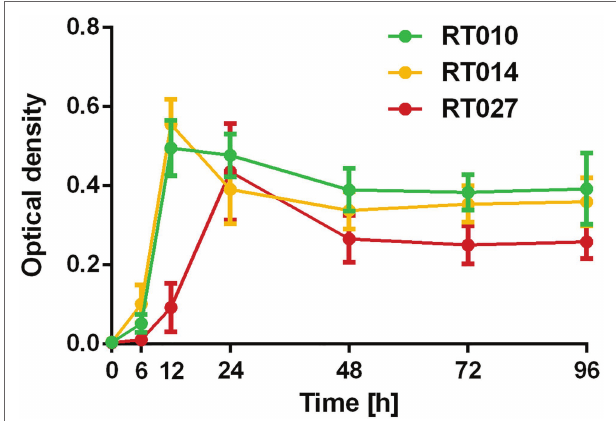
FIGURE 2 | Growth curve of C. difficile RT010 (green), RT014 (yellow), and RT027 (red). Conditioned media (BHI) were harvested after 0, 6, 12, 24, 48, 72, and 96 h anaerobic culture and optical density were